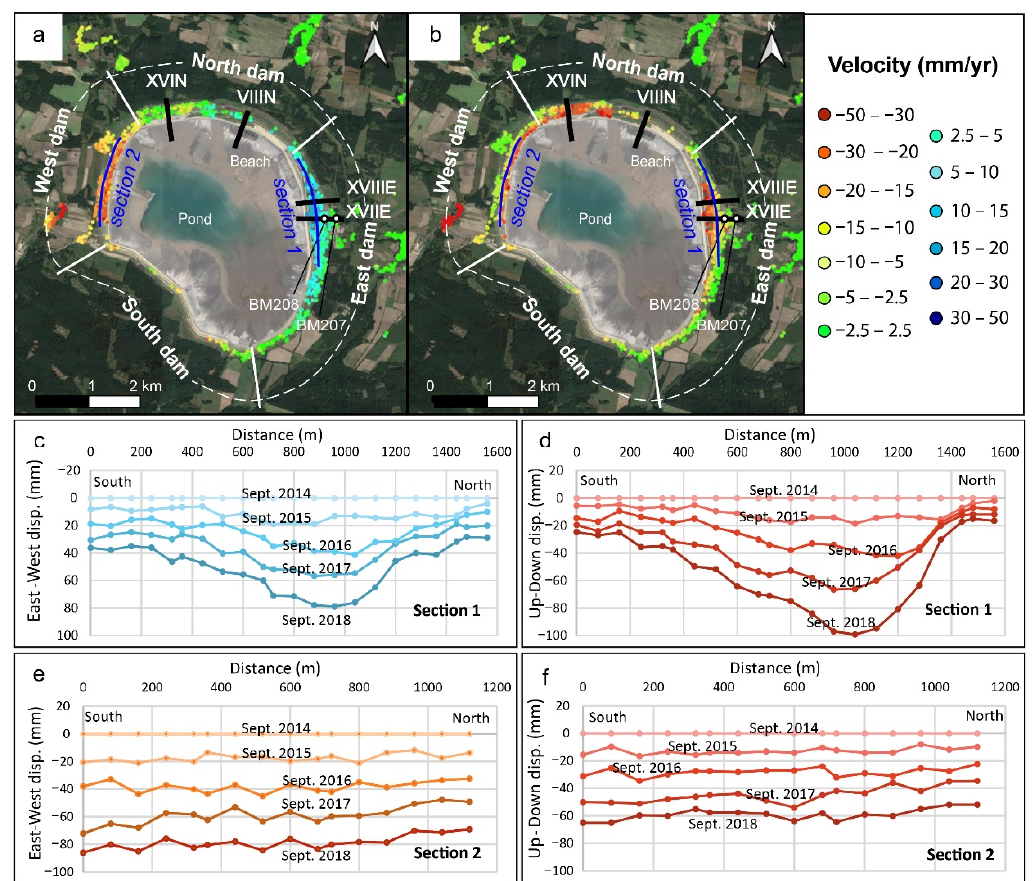
Figure 6. Longitudinal sections of cumulative displacement along the eastern dam (Section 1) and the western dam (Section 2); sections and dam sectors location are overlaid on ( a ) the east-west velocity map and ( b ) the up-down velocity map; ( c ) east-west displacement along the Section 1; ( d ) up-down displacement along the Section 1; ( e ) east-west displacement along the Section 2; ( f ) up-down displacement along the Section 2.